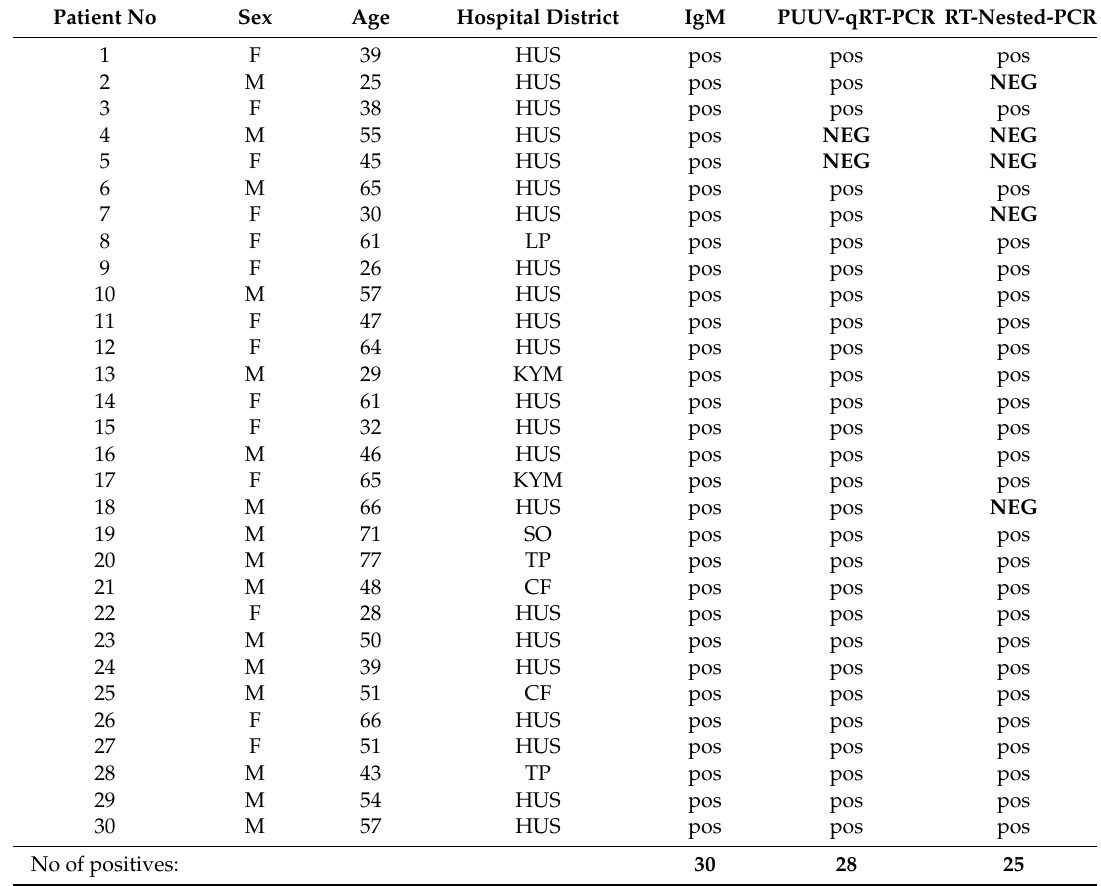
Table 1. Comparison of Puumala virus (PUUV) antibody and RNA